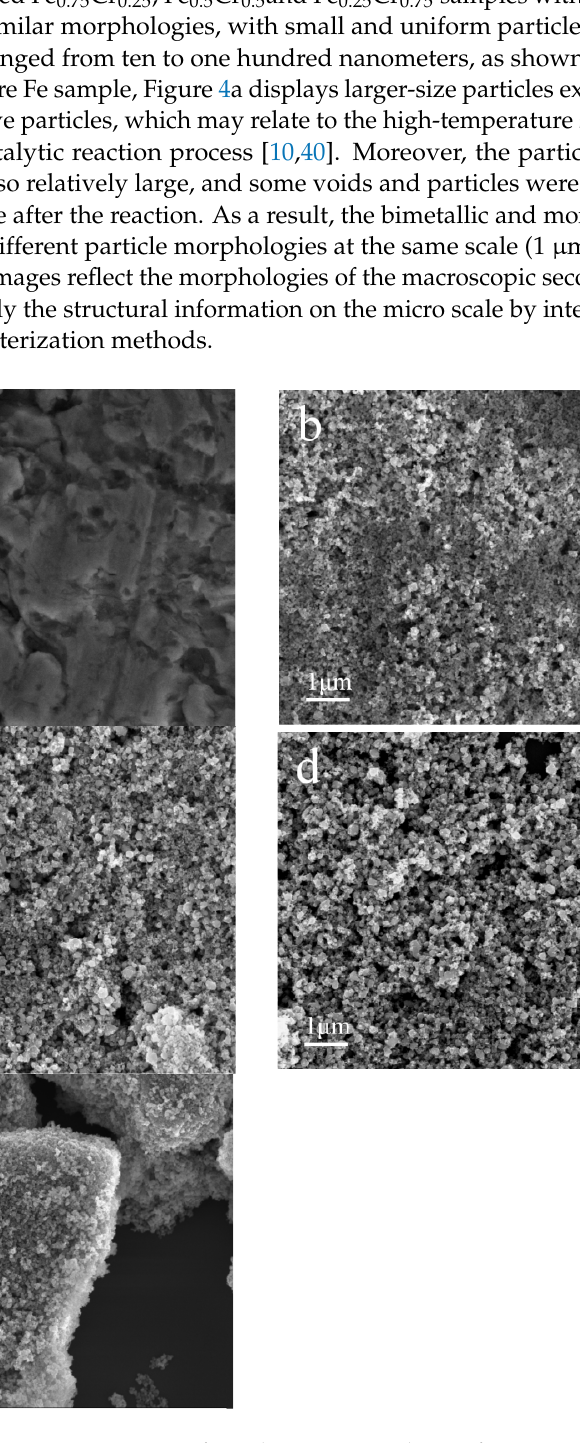
Figure 4. SEM images of used FeCrO x catalysts after NH 3 decomposition reaction: ( a ) Fe, ( b ) Fe 0.75 Cr 0.25 , ( c ) Fe 0.5 Cr 0.5 , ( d ) Fe 0.25 Cr 0.75 , and ( e ) Cr.